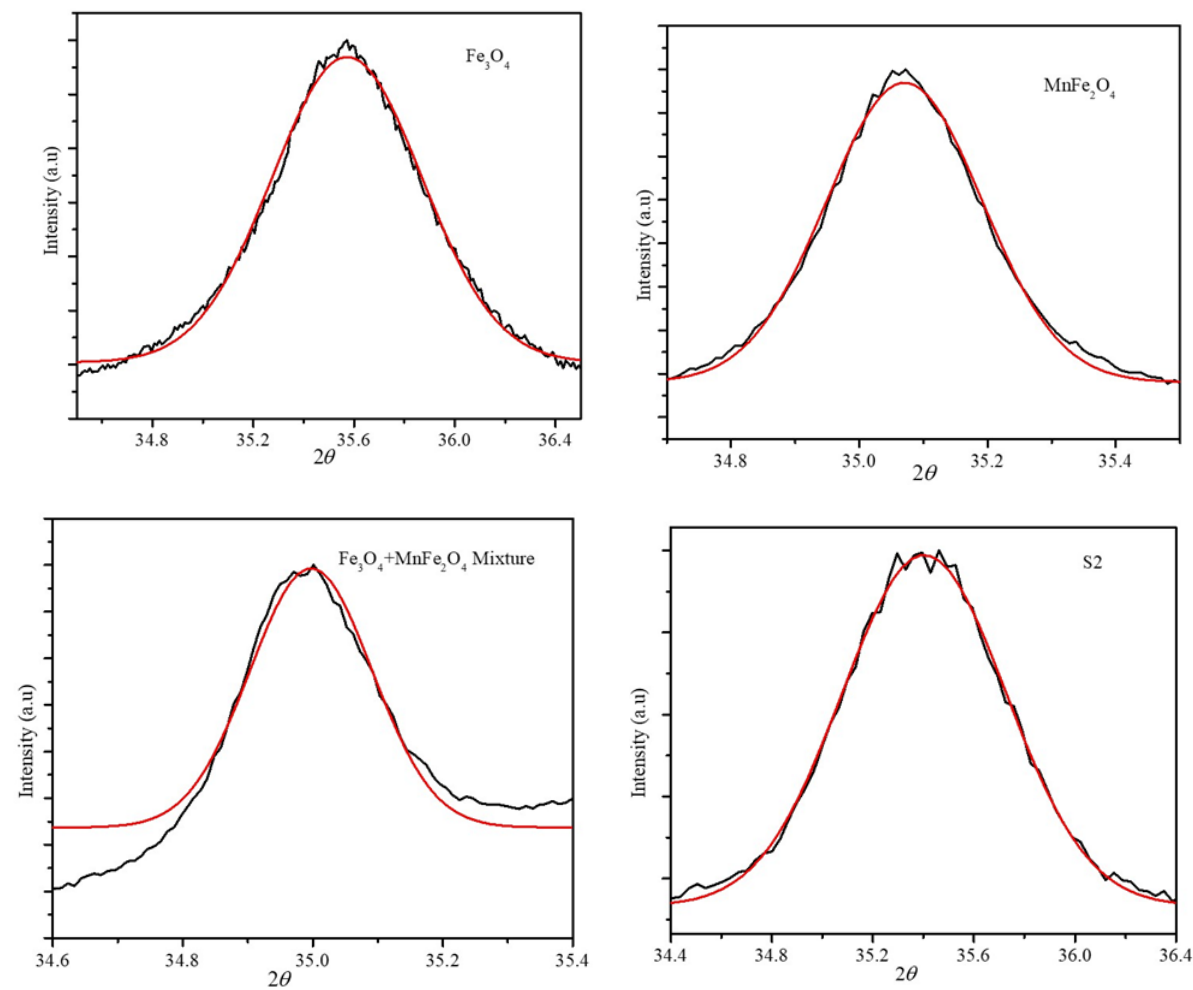
Figure 4. The (311) peak positions obtained from the Gaussian fitting of the XRD diffraction peak (Black-Experimental data and Red-Fitted data).